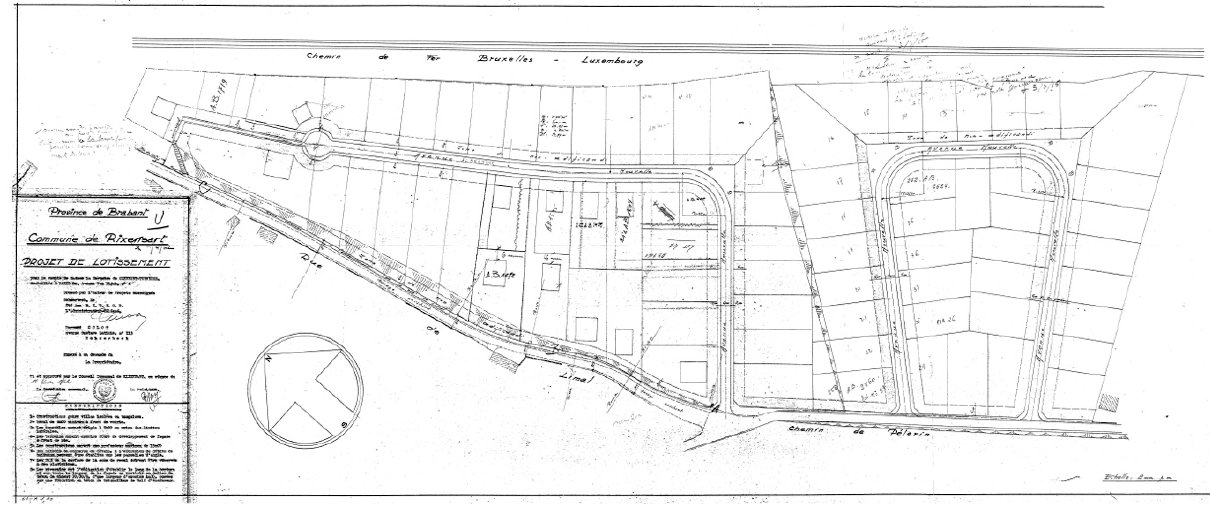
Figure 3. Example of a Rixensart allotment plan, Albertine, 1962. Source: Service Public de Wallonie, Lotissements (SPW-DG04,